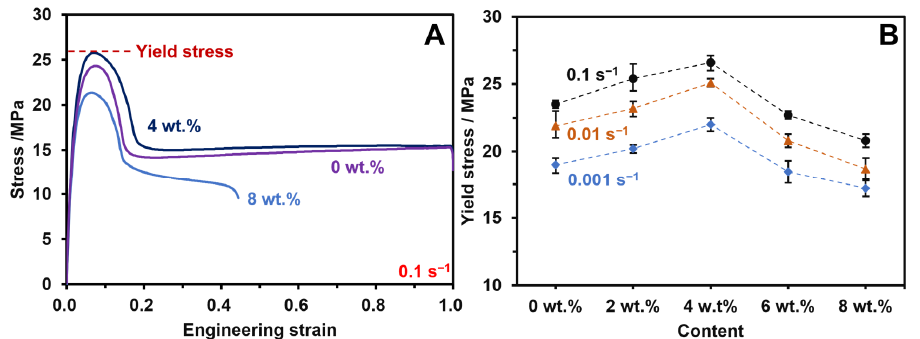
Figure 2. Strain-stress responses (from the tensile test) of the HDPE composites with different Si 3 N 4 contents: ( A ) strain-stress curves and ( B ) yield stresses with different strain